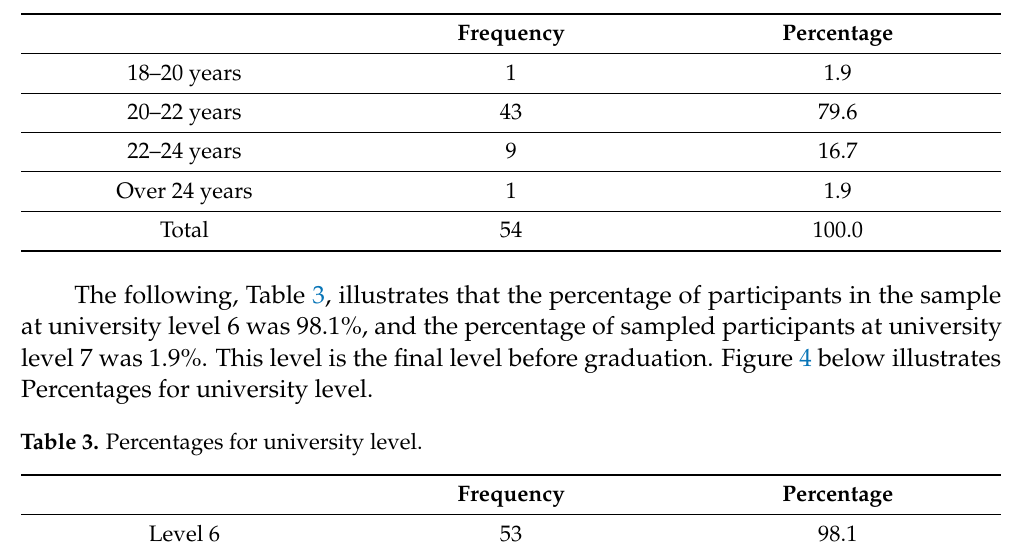
Table 2. Frequency table for age.